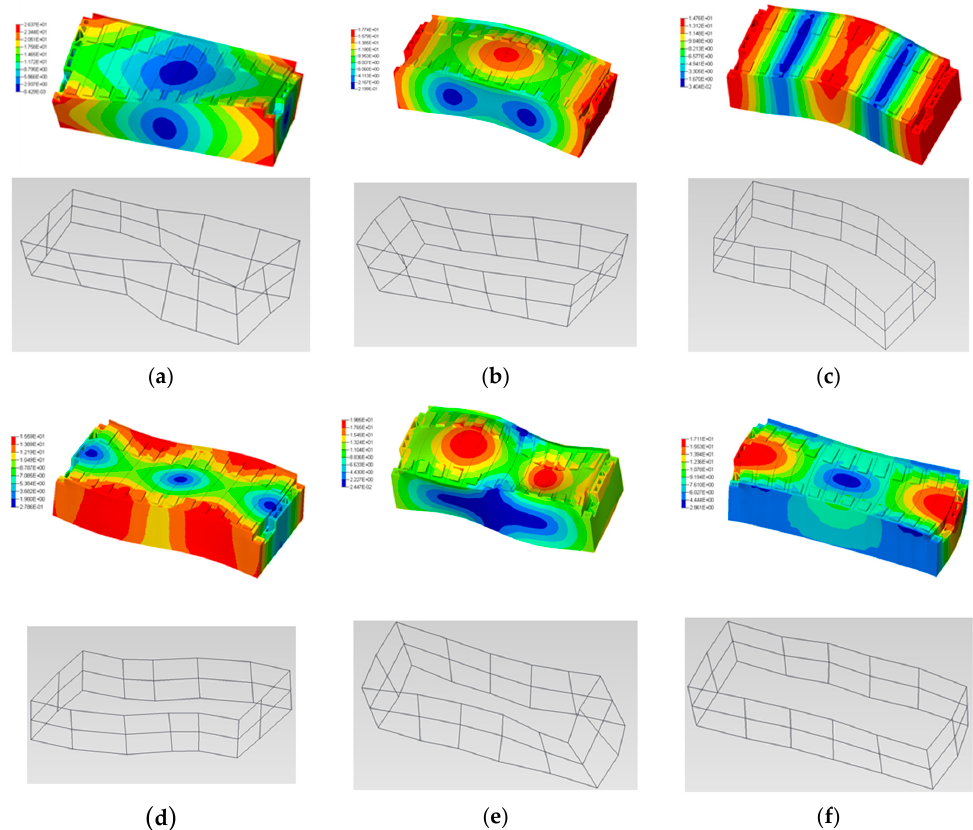
Figure 9. The comparison of mode shapes between the simulation and experimental results: ( a ) The first-order mode shape; ( b ) the second-order mode shape; ( c ) the third-order mode shape; ( d ) the fourth-order mode shape; ( e ) the fifth order mode shape; and ( f ) the sixth-order mode shape.